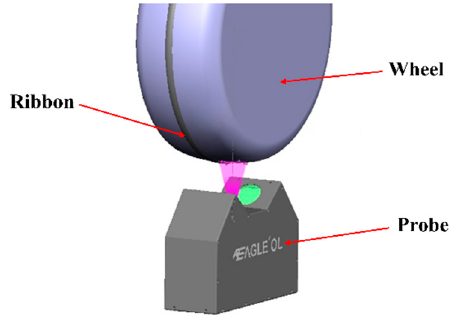
Figure 2. Magnetorheological polishing ribbon analysis device. ( a ) The schematic diagram of the magnetorheological polishing ribbon analysis device. ( b ) The magnetorheological polishing ribbon analysis device.